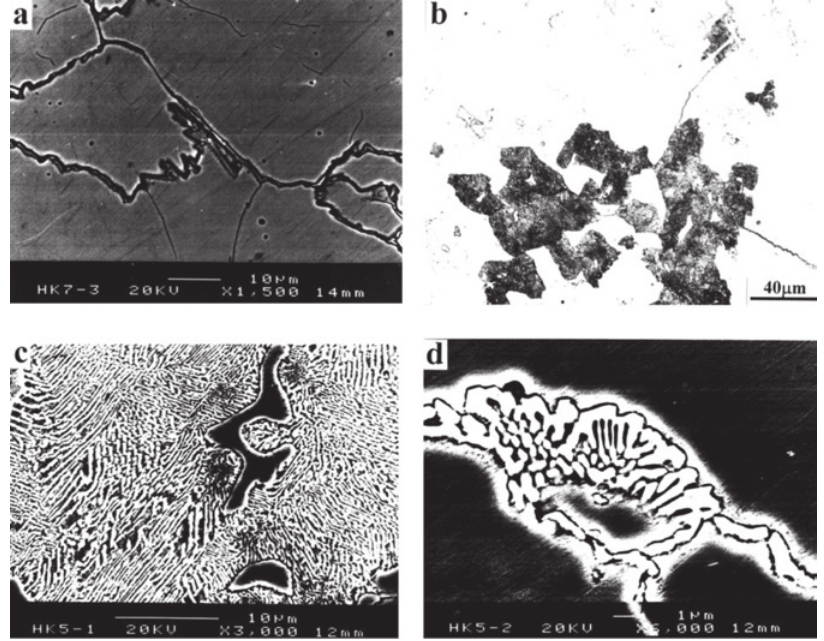
Fig. 4: Typical morphologies of the eutectic carbides in the tube (Fig. 3). (a) Thin film-like carbides in the zone A, (b) morphologies of the eutectic carbides in outer layer of zone B, (c) high magnification of lamellar carbide clusters shown in (b), and (d) the skeleton-like carbides in the zone C [12].